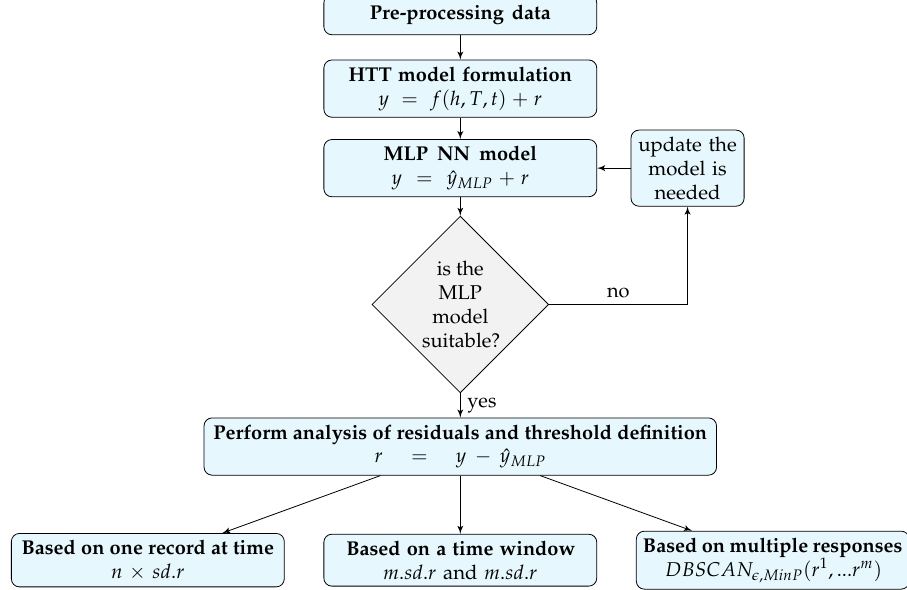
Figure 2. Proposed flowchart for the definition of thresholds for novelty